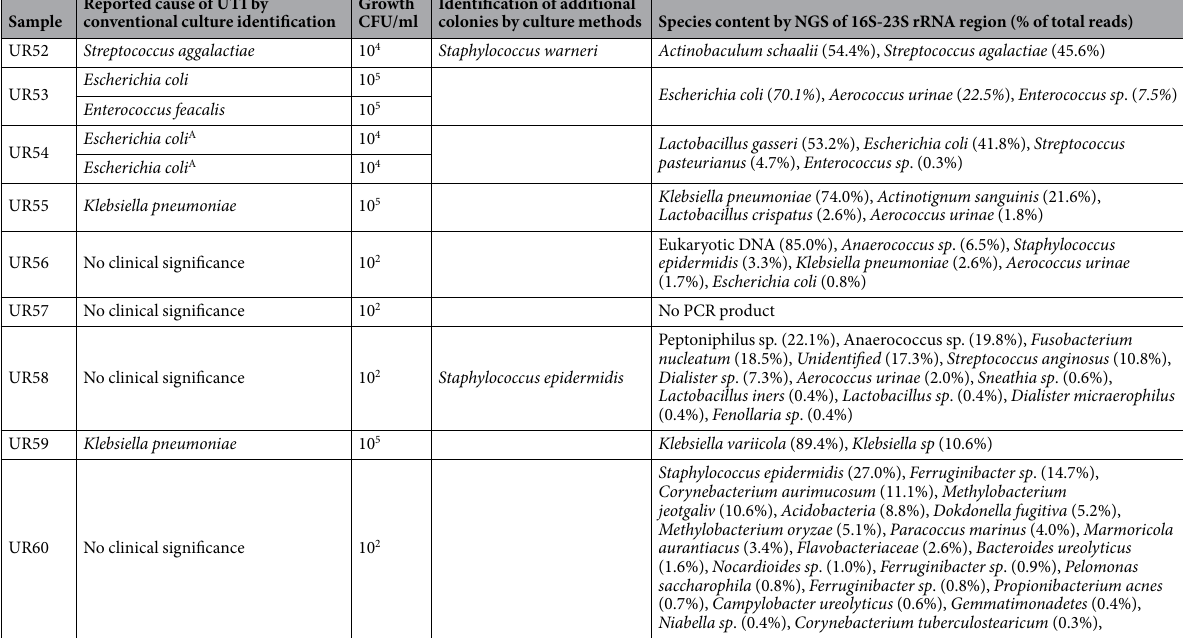
Next generation sequencing (NGS) allows culture free detection of a theoretically unlimited number of path- ogens and thus provides insight in the full microbiome. Since the introduction of benchtop sequencers, NGS is likely to become a diagnostic tool within the next few years in microbiological laboratories 3, 7, 8 . Metagenomics will be the ultimate approach in detecting all microorganisms (e.g. bacteria, viruses, fungi) in a sample. Unfortunately,